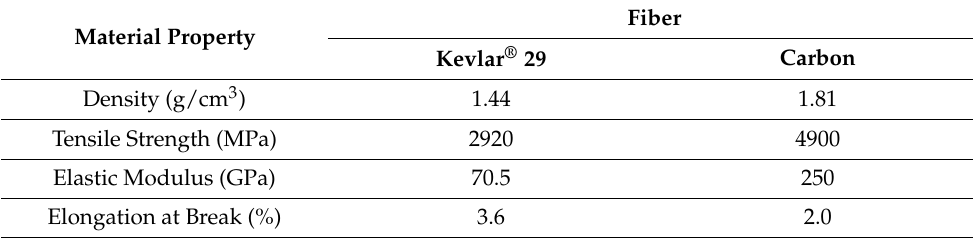
Table 1. Material properties of Kevlar ® 29 and carbon